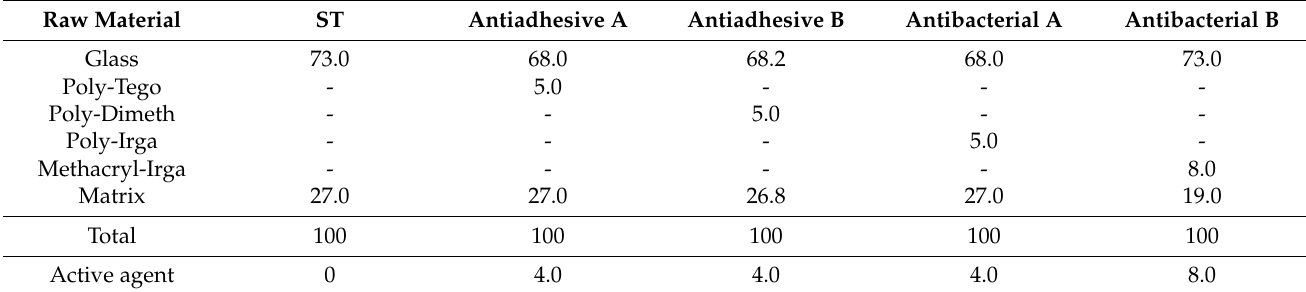
Table 1. Formulations of the experimental resin-based restorative materials and fraction of effective active agent in total mass. ST served as control (all data in wt %). Raw Material ST Antiadhesive A Antiadhesive B Antibacterial A Antibacterial B Glass 73.0 68.0 68.2 68.0 73.0 Poly-Tego - 5.0 - - - Poly-Dimeth - - 5.0 - Poly-Irga - - - Methacryl-Irga - - - - Matrix 27.0 27.0 26.8 27.0 Total 100 100 100 100 100 Active agent 0